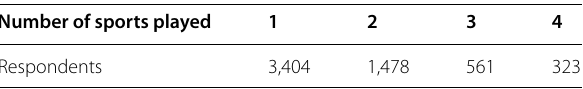
Table 3 Distribution of respondents by the number of